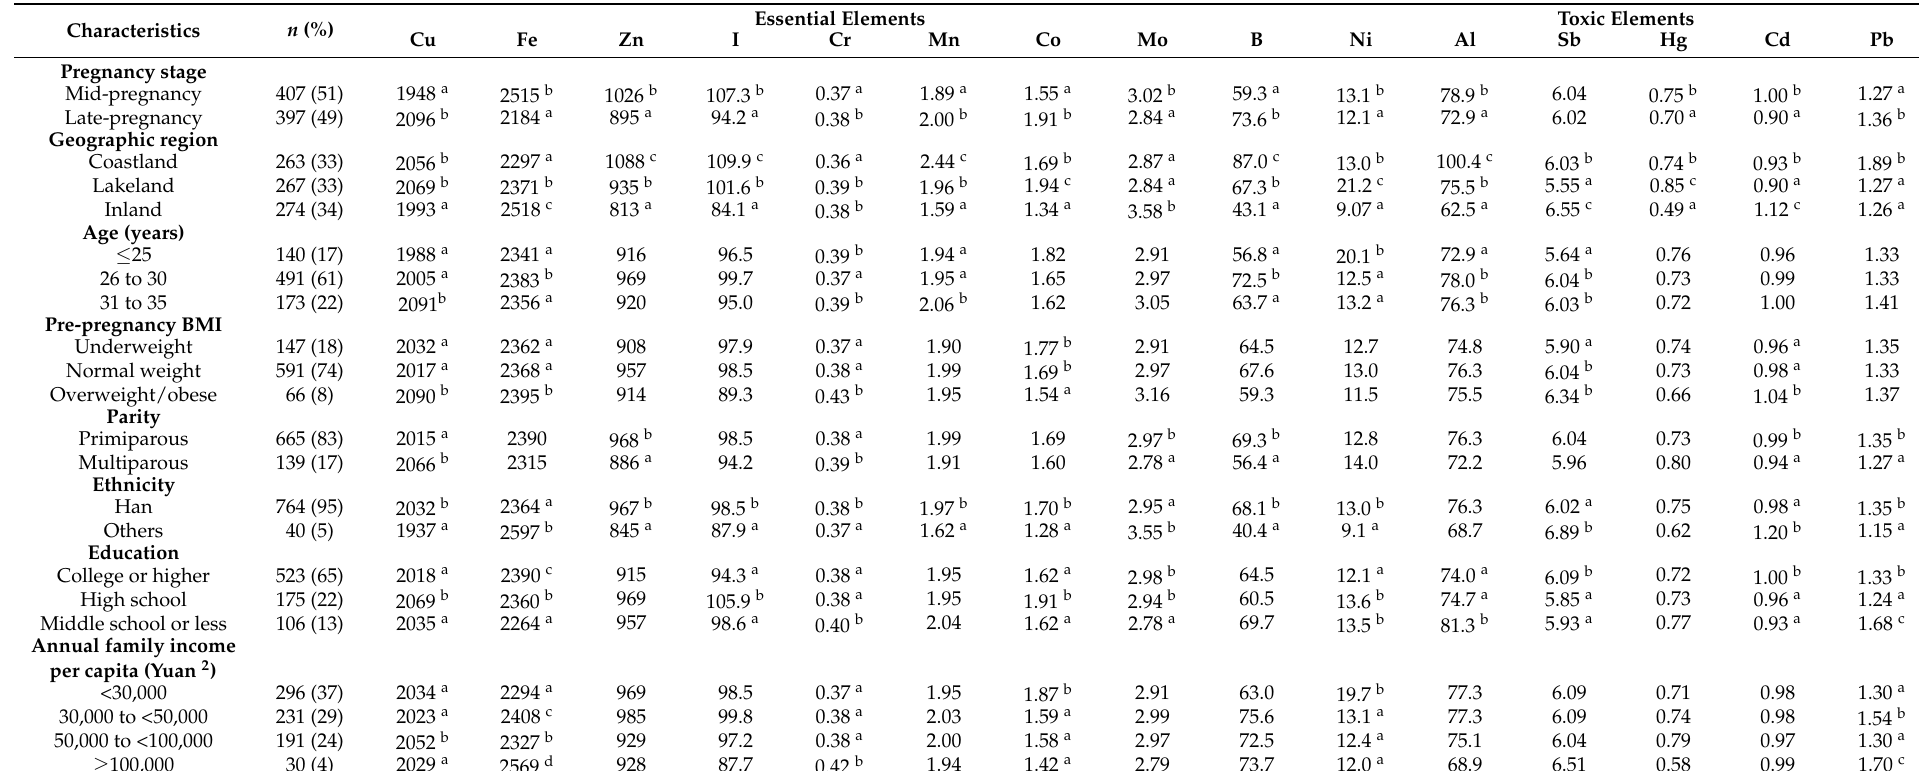
Table 2. Adjusted median concentrations (ng/mL) of plasma essential and toxic elements by characteristics of pregnant women ( n = 804) 1